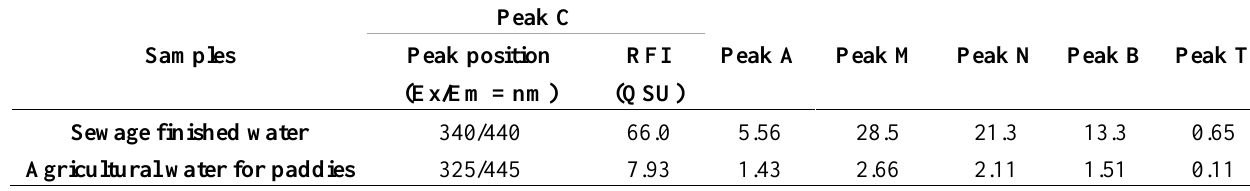
Table 3. The RFI of each peak obtained from 3DEEM spectra of the sewage treatment water and agricultural water for paddy. The RFI values for the peak A, peak M, peak N, peak B and peak T were selected from the peak position at 240/420, 290/370, 280/370, 270/370 and 220/345 (Ex./Em.)